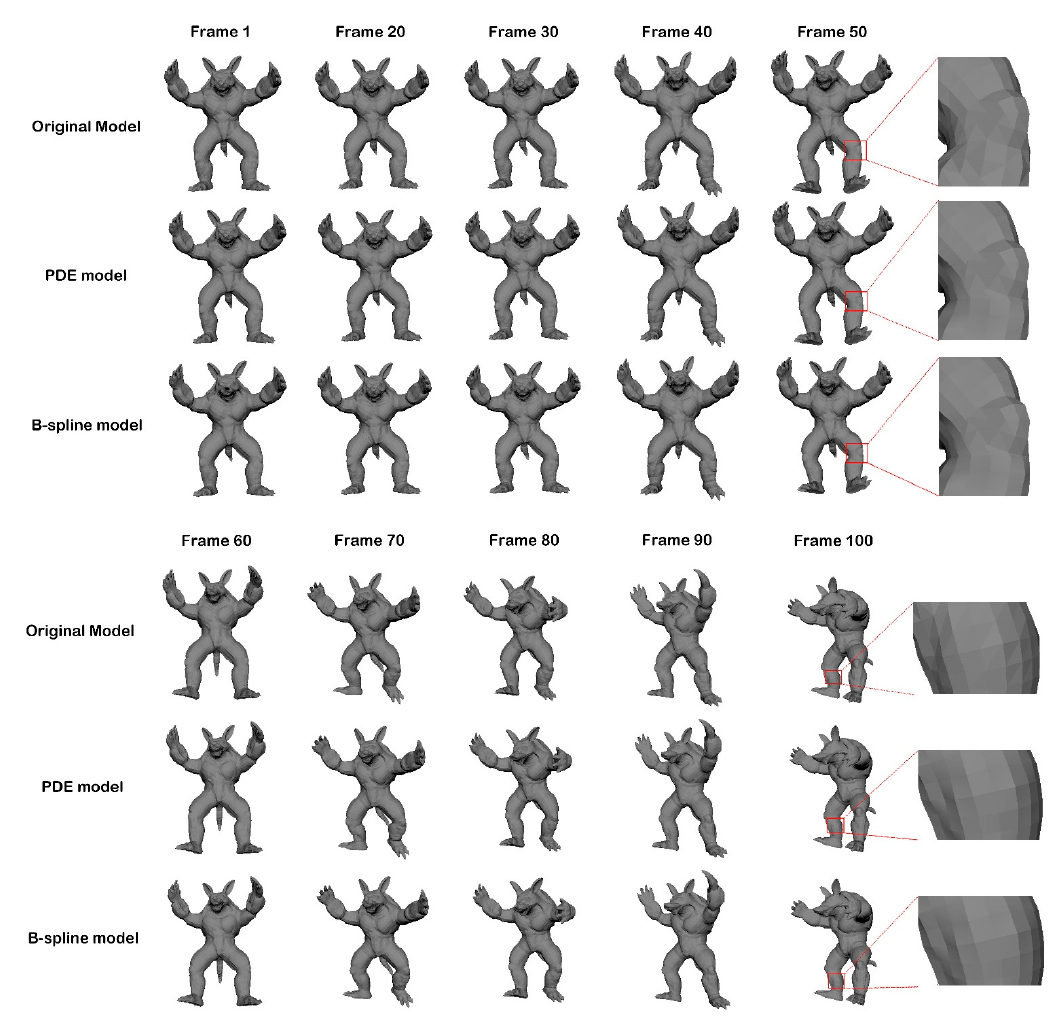
Figure 7. Original deformed shapes and reconstructed shapes of an armadillo model at keyframes 1, 20, 30, 40, 50, 60, 70, 80, 90, and 100.